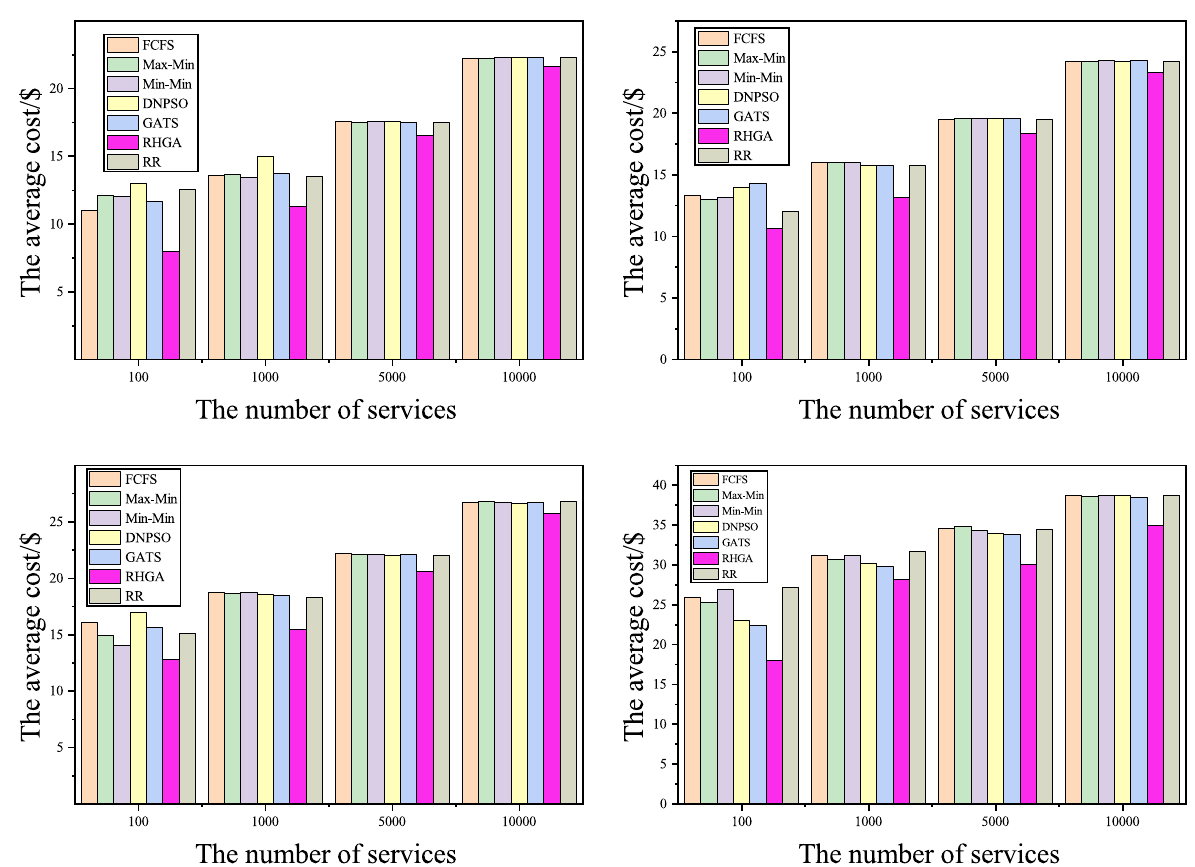
Fig. 8 The average cost of various